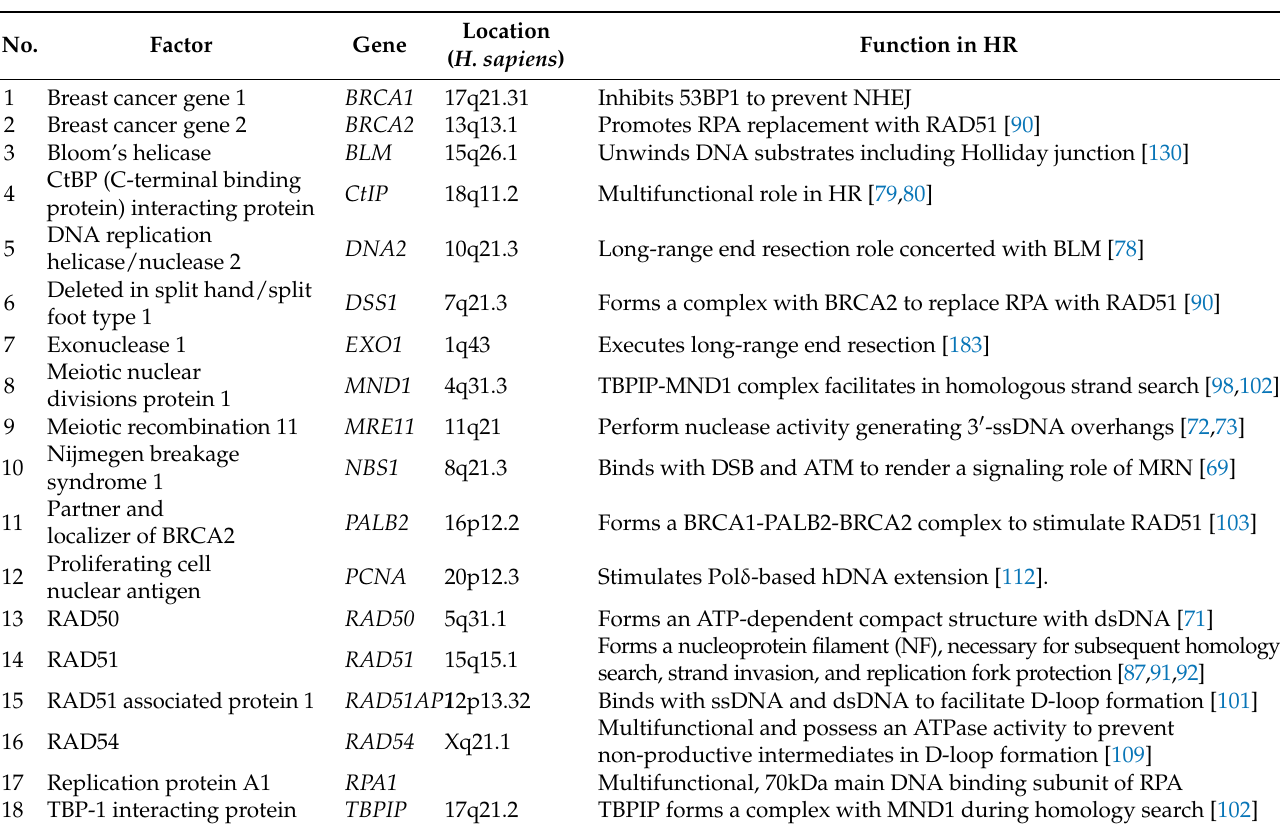
Table 2. Key molecules associated with the HR repair pathway and their gene location based on human genome assembly